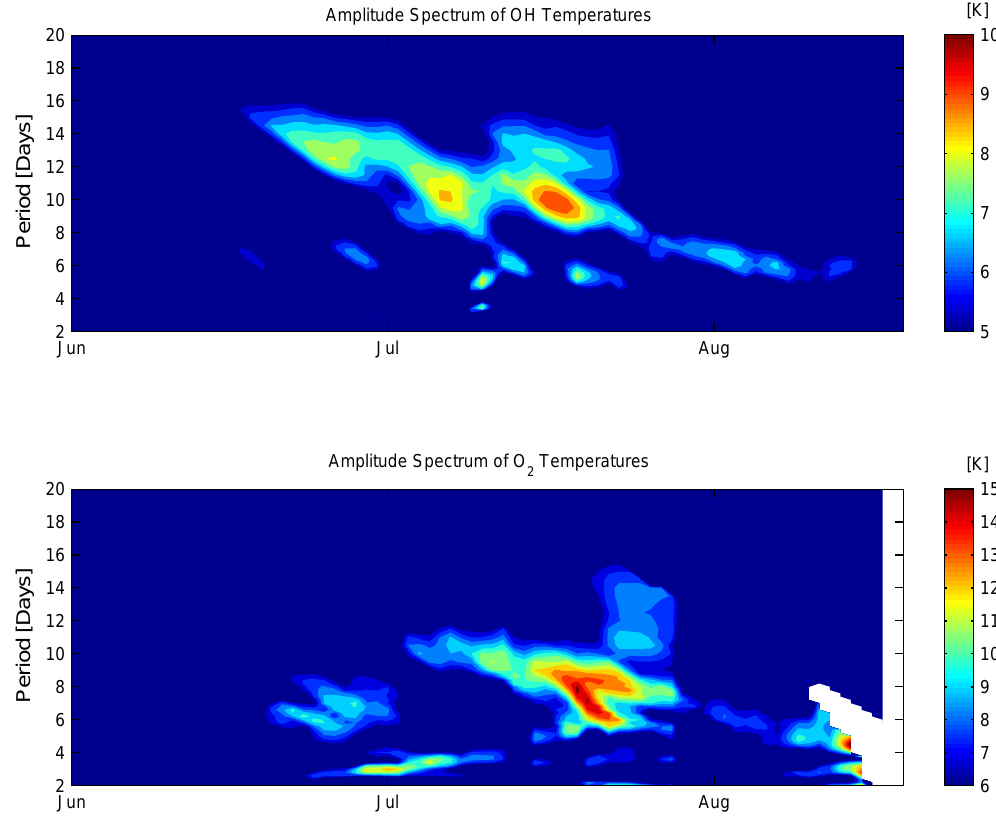
Fig. 6. Wavelet amplitude spectra of OH temperatures (top) and O 2 temperatures (bottom) showing amplification of 5–10 day wave activity prior to the onset of SSW and coinciding with the MLT temperature anomalies seen in Fig.